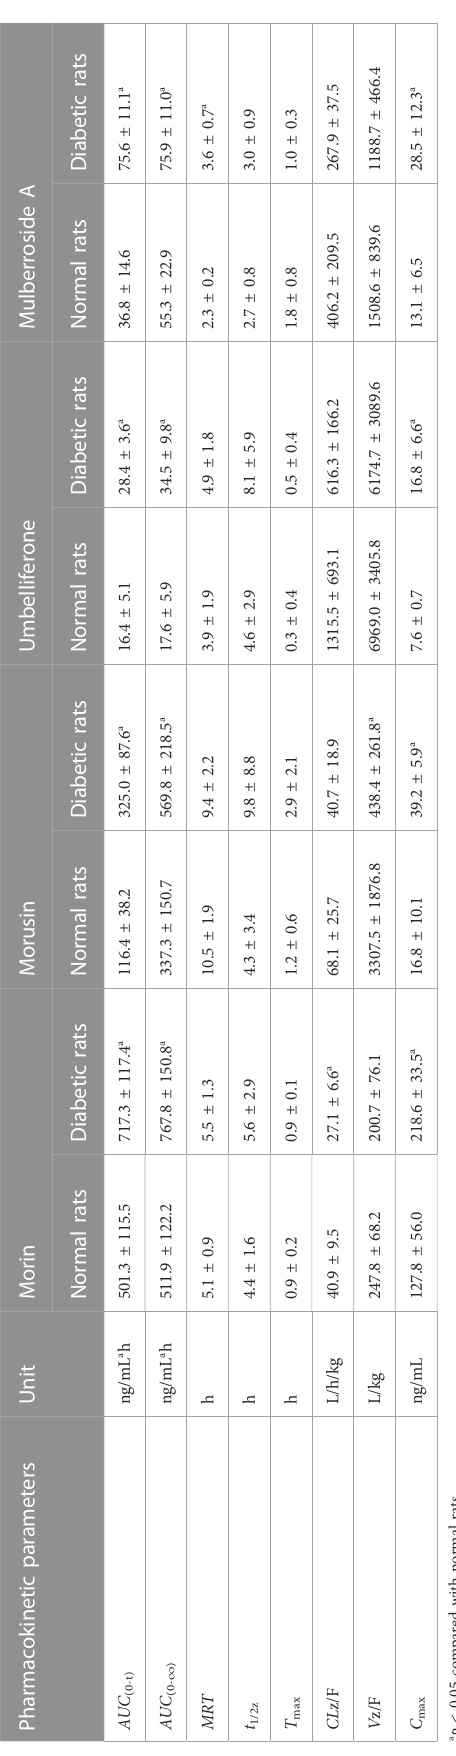
signi fi cant increased ( p < 0.05), compared with those obtained from the normal rats. Signi fi cant differences in